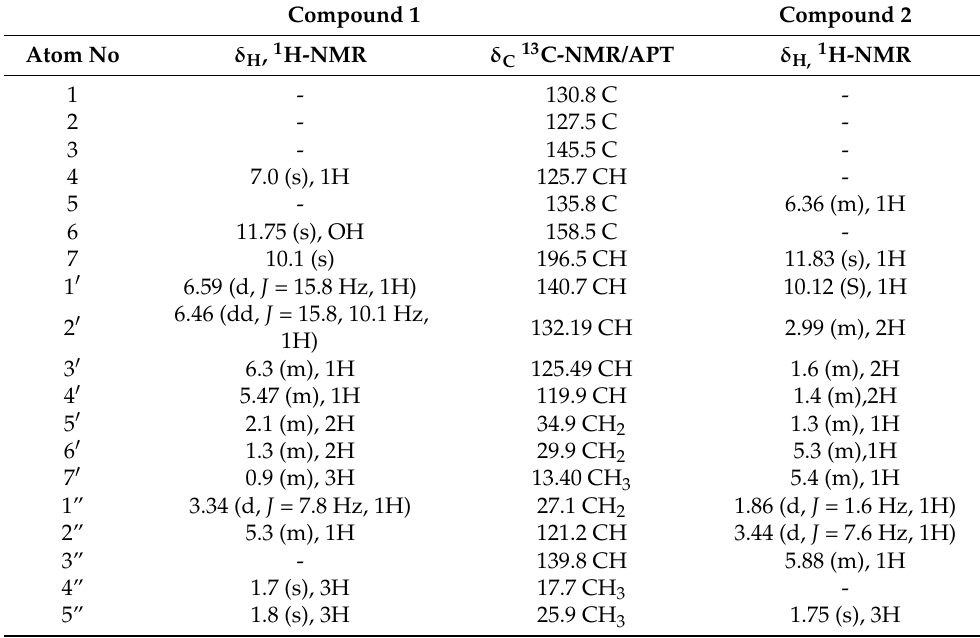
Figure 1. The chemical structures of the isolated compounds from the fungal ethyl acetate extract (FEA). Table 1. 1 H-NMR and 13 C-NMR of prenylated benzaldehyde derivatives isolated from A. niger